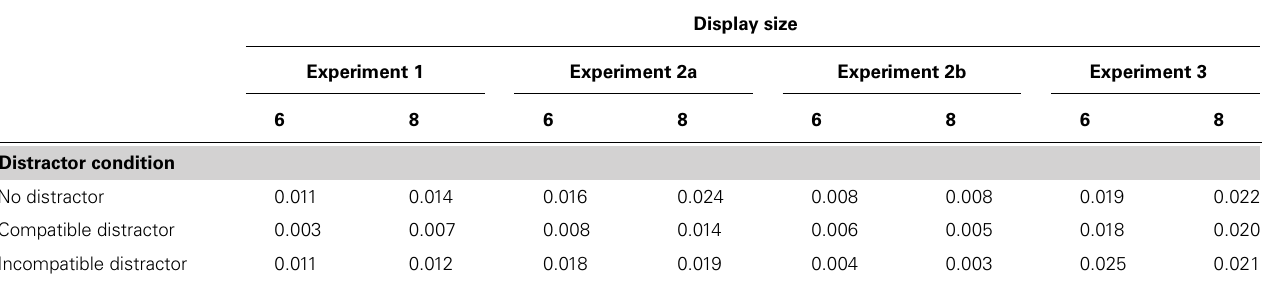
Table 1 | Mean error rate as a function of distractor condition and display size for Experiments 1, 2a, 2b, and